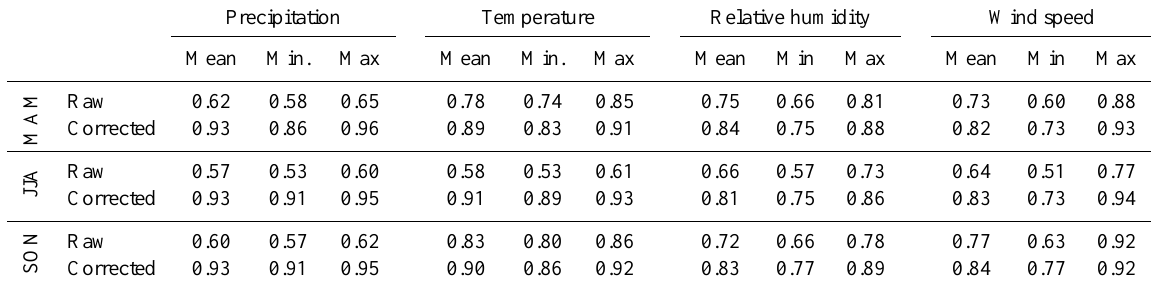
Table 4. PDF skill scores (SS) of data from raw and corrected RCA3-E5r3-A1B (1986–2005), averaged over 14 Swedish stations. Precipitation Temperature Relative humidity Wind speed Mean Min. Max Mean Min. Max Mean Min Max Mean Min Max M Raw 0.62 0.58 0.65 A M A JJ